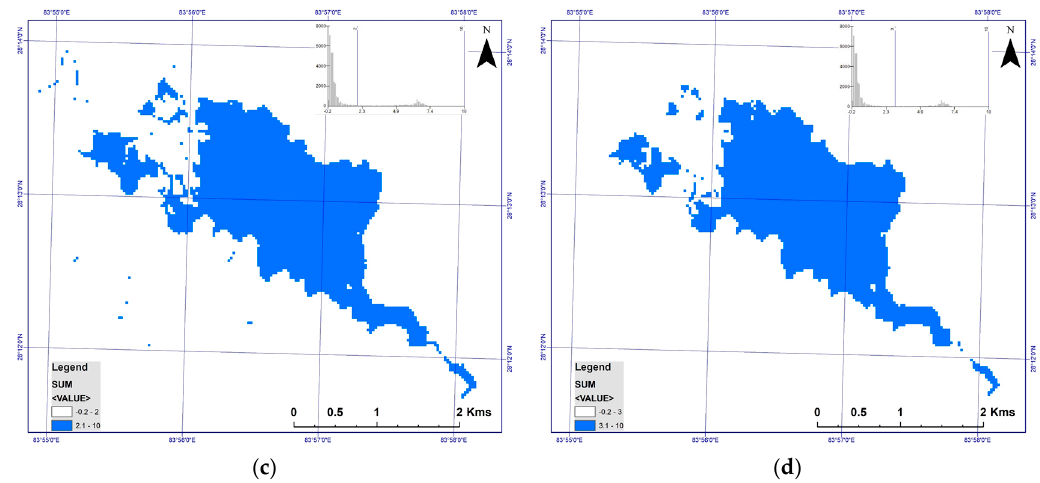
Figure 4. Result of sum of indices & threshold from Landsat 8 OLI image: ( a ) Index; ( b ) 1; ( c ) 2; ( d )